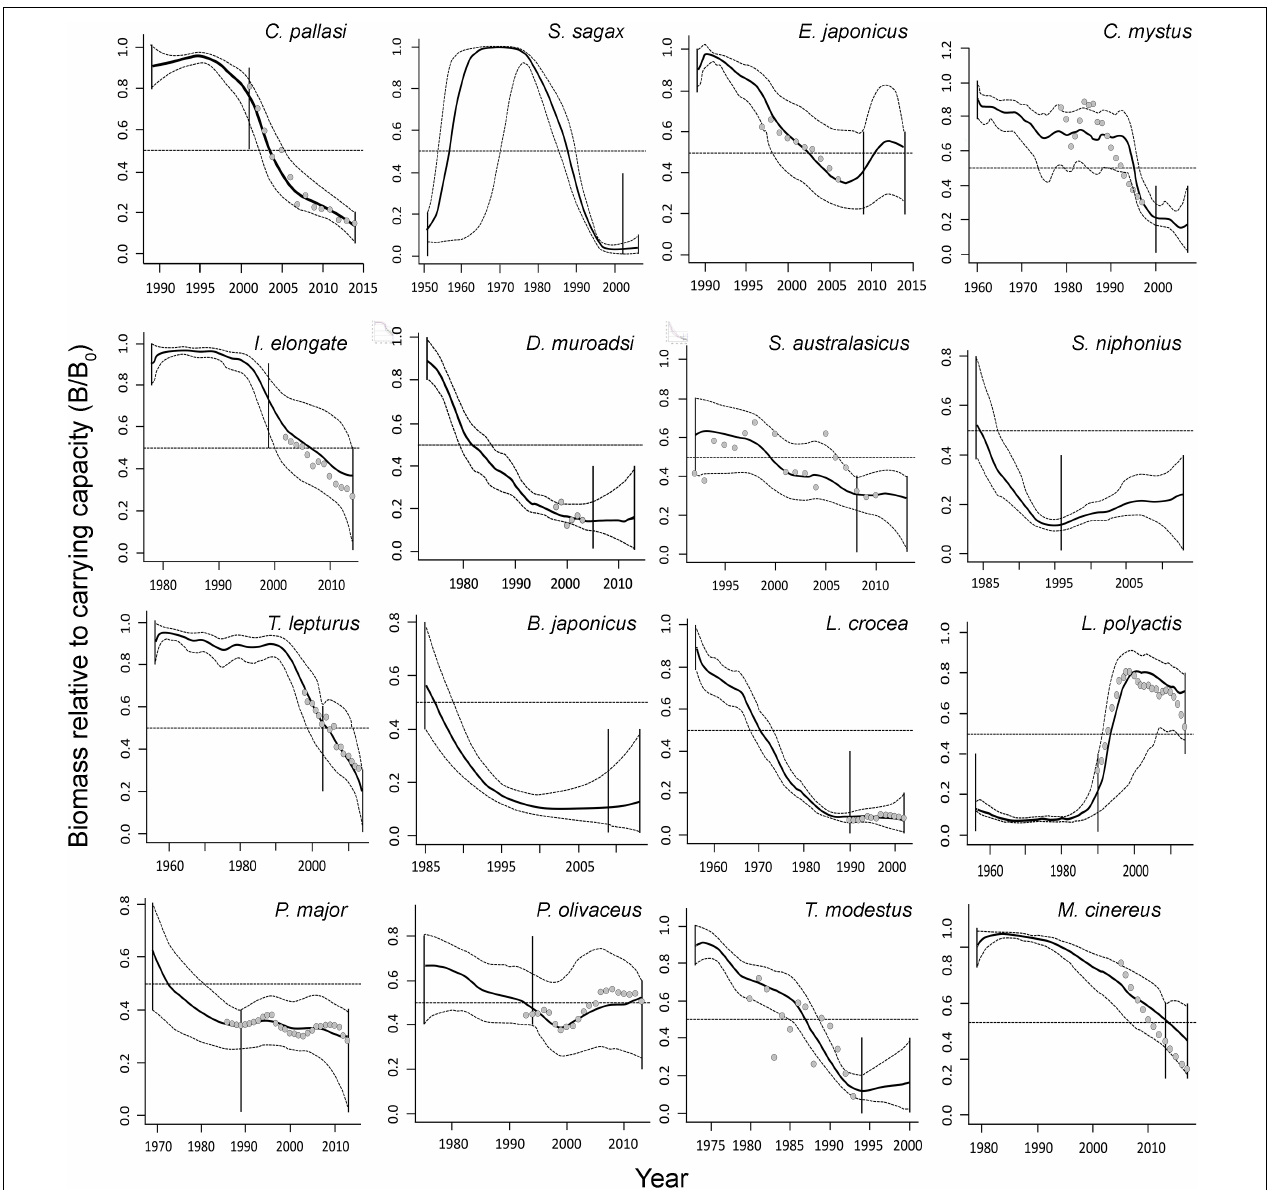
FIGURE 2 | Biomass trajectories of 16 single-species stocks in Table 1 , as estimated by the CMSY method (solid black lines) and their uncertainty (gray dashed lines), related abundance series (gray dots; SSB and corrected CPUE by 2% every year), when available, and vertical lines represented priors (from Tables 3 , 4 ). Except for S. sagax (see text), all of these trajectories are due to excessively high catches.